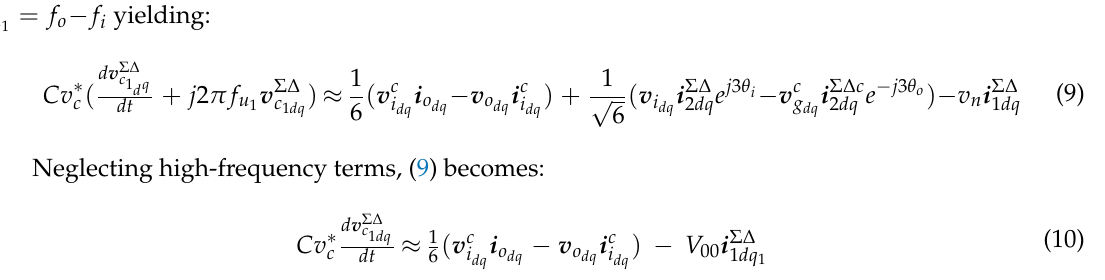
and Different Frequencies Mode (DFM) of v Σ∆ c 1 αβ and v 0 c 0 αβ